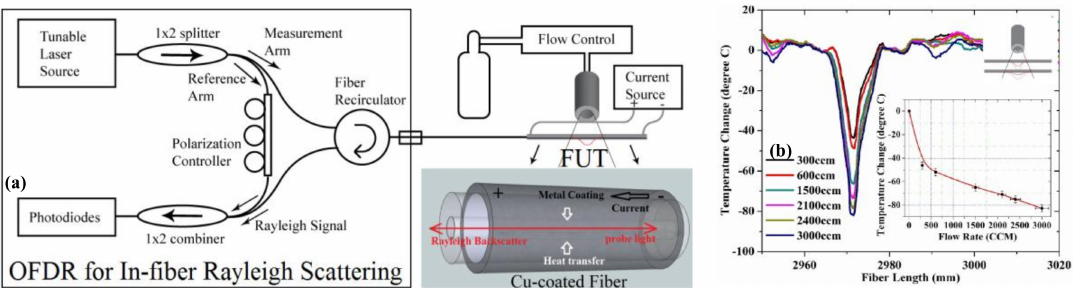
Figure 33. ( a ) Experimental setup of distributed hot-wire flow sensing using OFDR. ( b ) (Color Online) A local flow-induced temperature variation and flow rate sensitivity curve (reprinted from Chen et al. [73] with permission of OSA; copyright